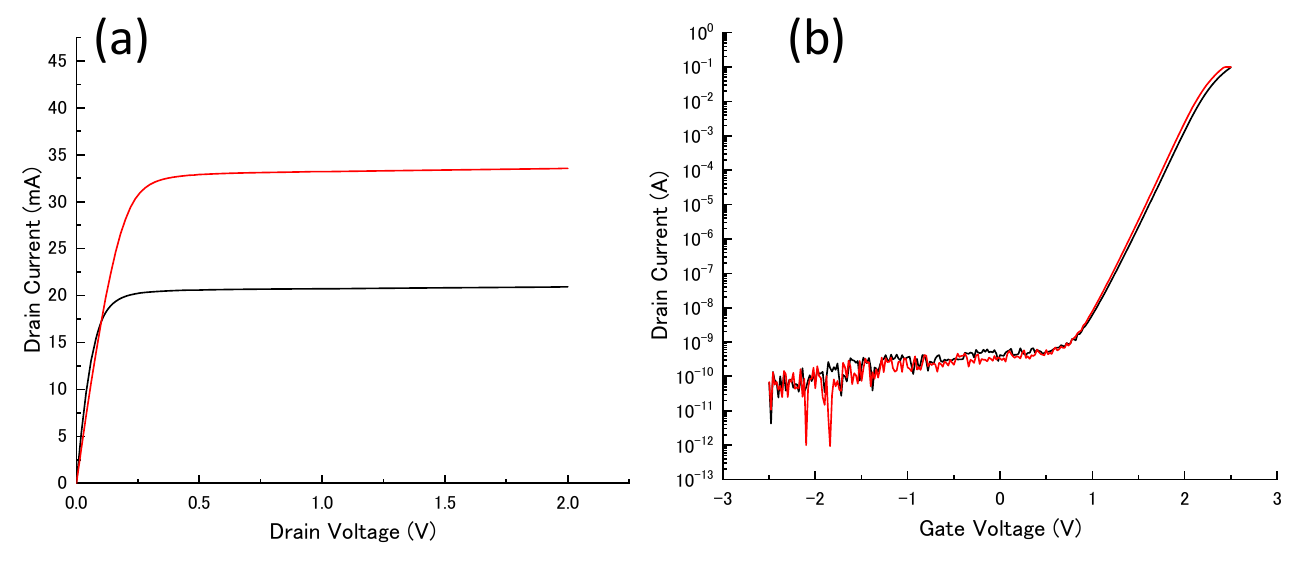
Figure 8. Characteristic curves after microwave heating (red) and before microwave heating (black) of output characteristic ( a ) and transfer characteristic ( b ). Table 1. Summary of characteristic values of MOSFET after microwave heating.